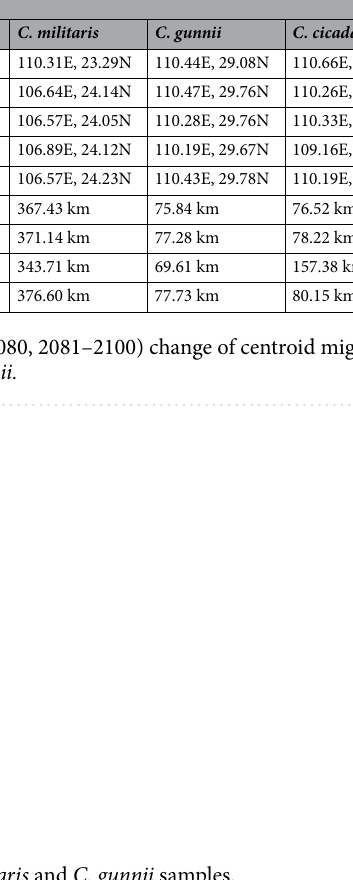
Table 4. Source information of C. sinensis , C. cicadae , C. militaris and C. gunnii samples.